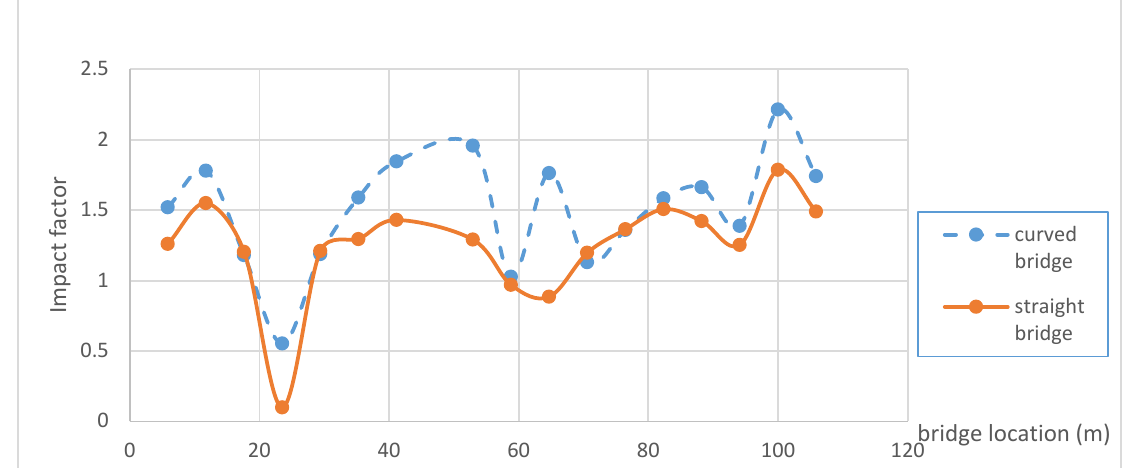
Fig. 6. Impact factor comparison between curved and hypothetical straight Manchuria